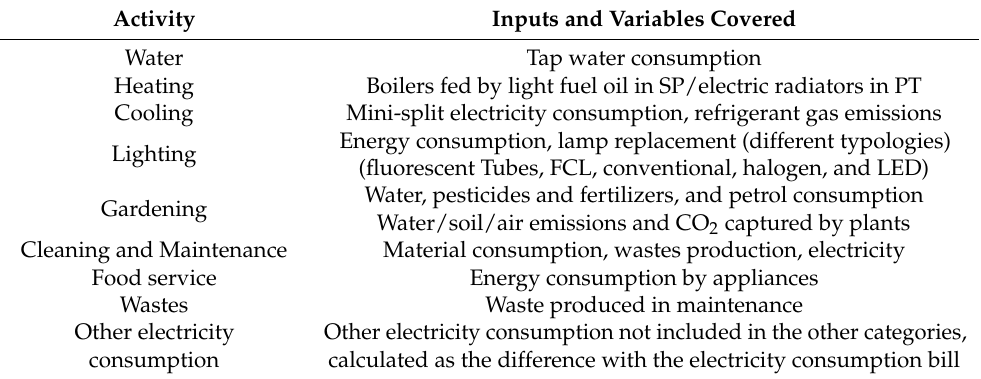
Figure 1. Diagram of the school system under the LCA approach. E: energy; m: materials. Table 2. Activities included in subsystem 1 (management of the building).